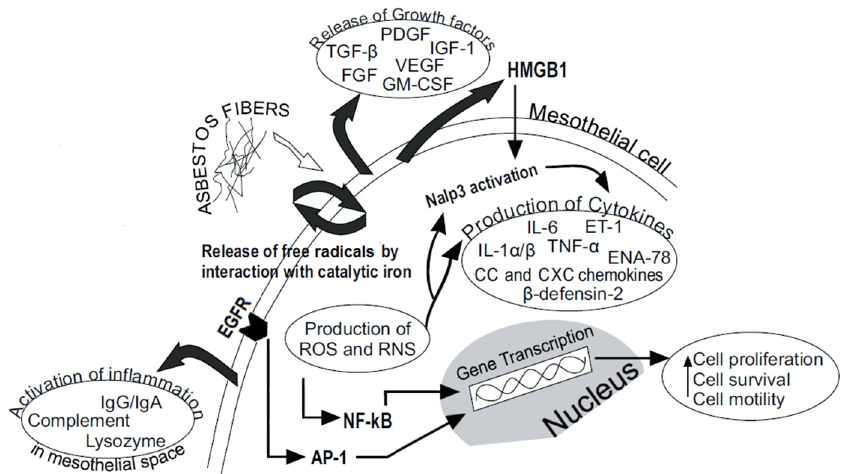
Figure 1. The asbestos ‐ mediated long ‐ lasting inflammation in mesothelial cells. Biological responses of mesothelial cells to asbestos fiber injury. Abbreviations: ROS, Reactive Oxygen Species; RNS, Reactive Nitrogen Species; HMGB1, High ‐ Mobility Group Box 1 Protein; PDGF, Platelet ‐ Derived Growth Factors; FGF, Fibroblast Growth Factor; IGF ‐ 1, Insulin ‐ Like Growth Factor ‐ 1; VEGF, Vascular Endothelial Growth Factor; TGF ‐β , Transforming Growth Factor ‐β ; GM ‐ CSF, Granulocyte/Macrophage ‐ Colony Stimulating Factor; IL ‐ 6, Interleukin ‐ 6; ET ‐ 1, Endothelin ‐ 1; IL ‐ 1 α / β , Interleukin ‐ 1 α / β ; TNF ‐α , Tumor Necrosis Factor ‐α ; ENA ‐ 78, Epithelial Neutrophil Activating Protein ‐ 78; NF ‐κ B, Nuclear Factor ‐ kB; EGFR, Epidermal Growth Factor Receptor; AP ‐ 1, Activator Protein ‐ 1.